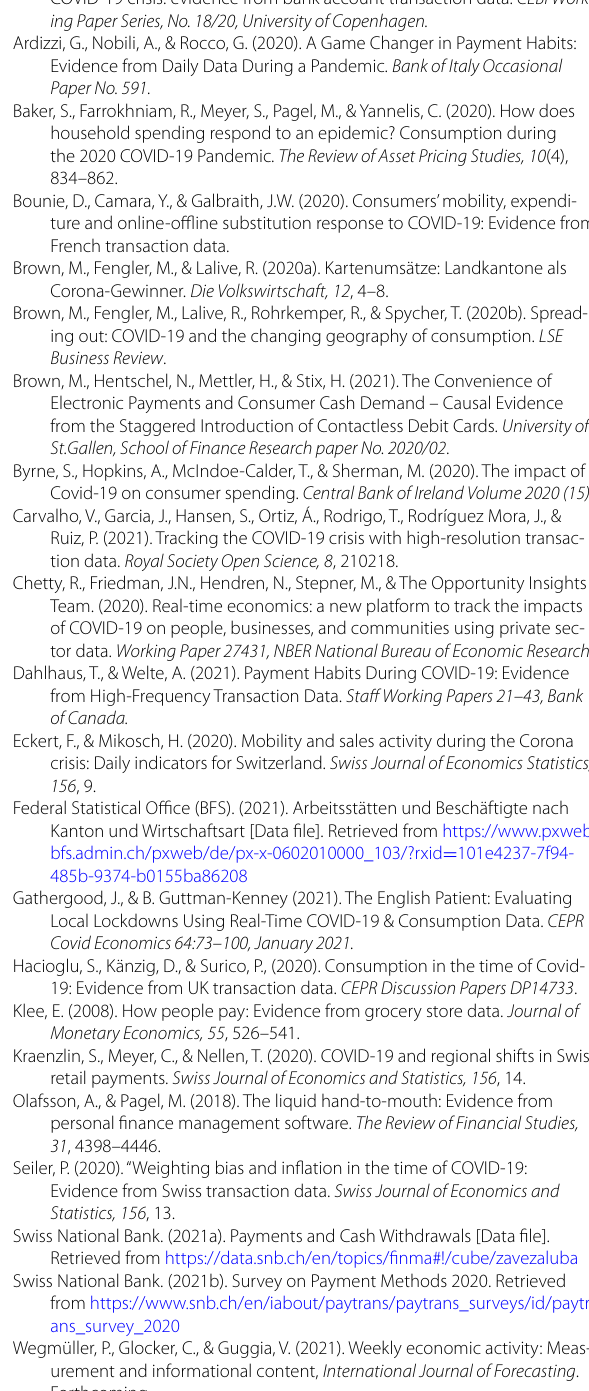
Table 4 Overview of attributes in the acquiring and issuing